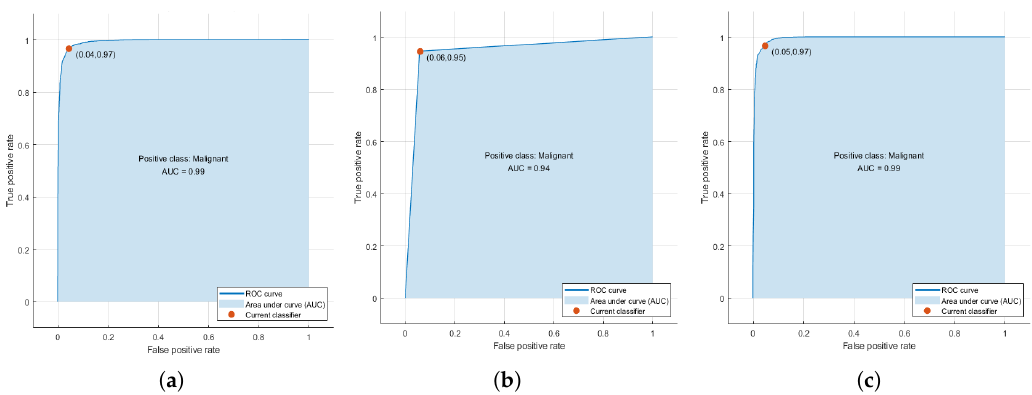
Figure 8. ( a ) Receiver operating characteristic (ROC) curves obtained during training phase for the three selected algorithms. ( a ) Support Vector Machines (SVM), ( b ) AdaBoost , and ( c ) K-Nearest Neighbour (KNN). The higher accuracy value achieved is obtained only with the training set that is highly correlated with Tumour Cellularity